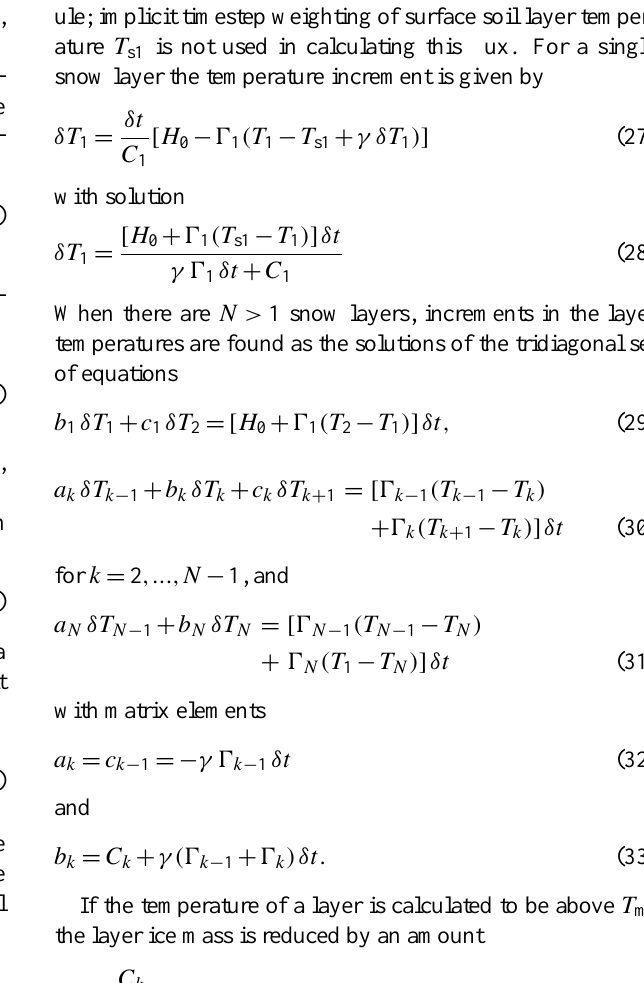
Table 5. Default parameter values required by JULES for the standard vegetation surfaces. Parameter Broadleaf Needleleaf C3 C4 Shrubs trees trees grasses grasses Snow-covered albedo for large LAI 0.15 0.15 0.60 0.60 0.40 Snow-covered albedo for zero LAI 0.30 0.30 0.80 0.80 0.80 Snow-free albedo for large LAI 0.10 0.10 0.20 0.20 0.20 Rate of change of vegetation roughness 0.05 0.05 0.10 0.10 0.10 length with height Minimum canopy capacity (kgm − 2 ) 0.50 0.50 0.50 0.50 0.50 Rate of change of canopy capacity 0.05 0.05 0.05 0.05 0.05 with LAI Infiltration enhancement factor 4.00 4.00 2.00 2.00 2.00 Light extinction coefficient 0.50 0.50 0.50 0.50 0.50 Rootdepth (m) 3.00